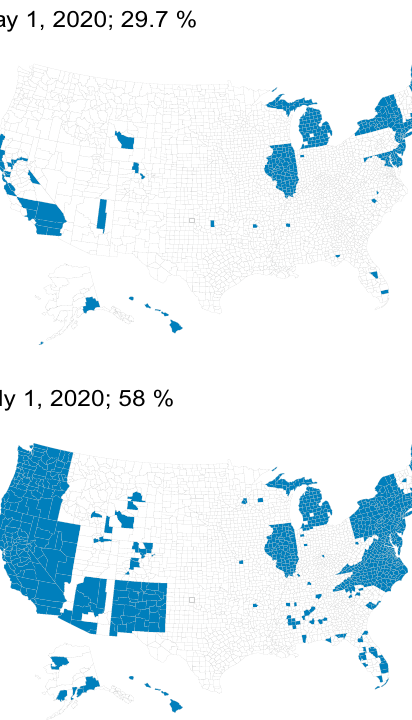
Figure 3. Counties under a mask mandate. Percentages indicate the share of the U.S. population under a mask mandate on the corresponding date. Mandate data are acquired from Wright et al. 49 .